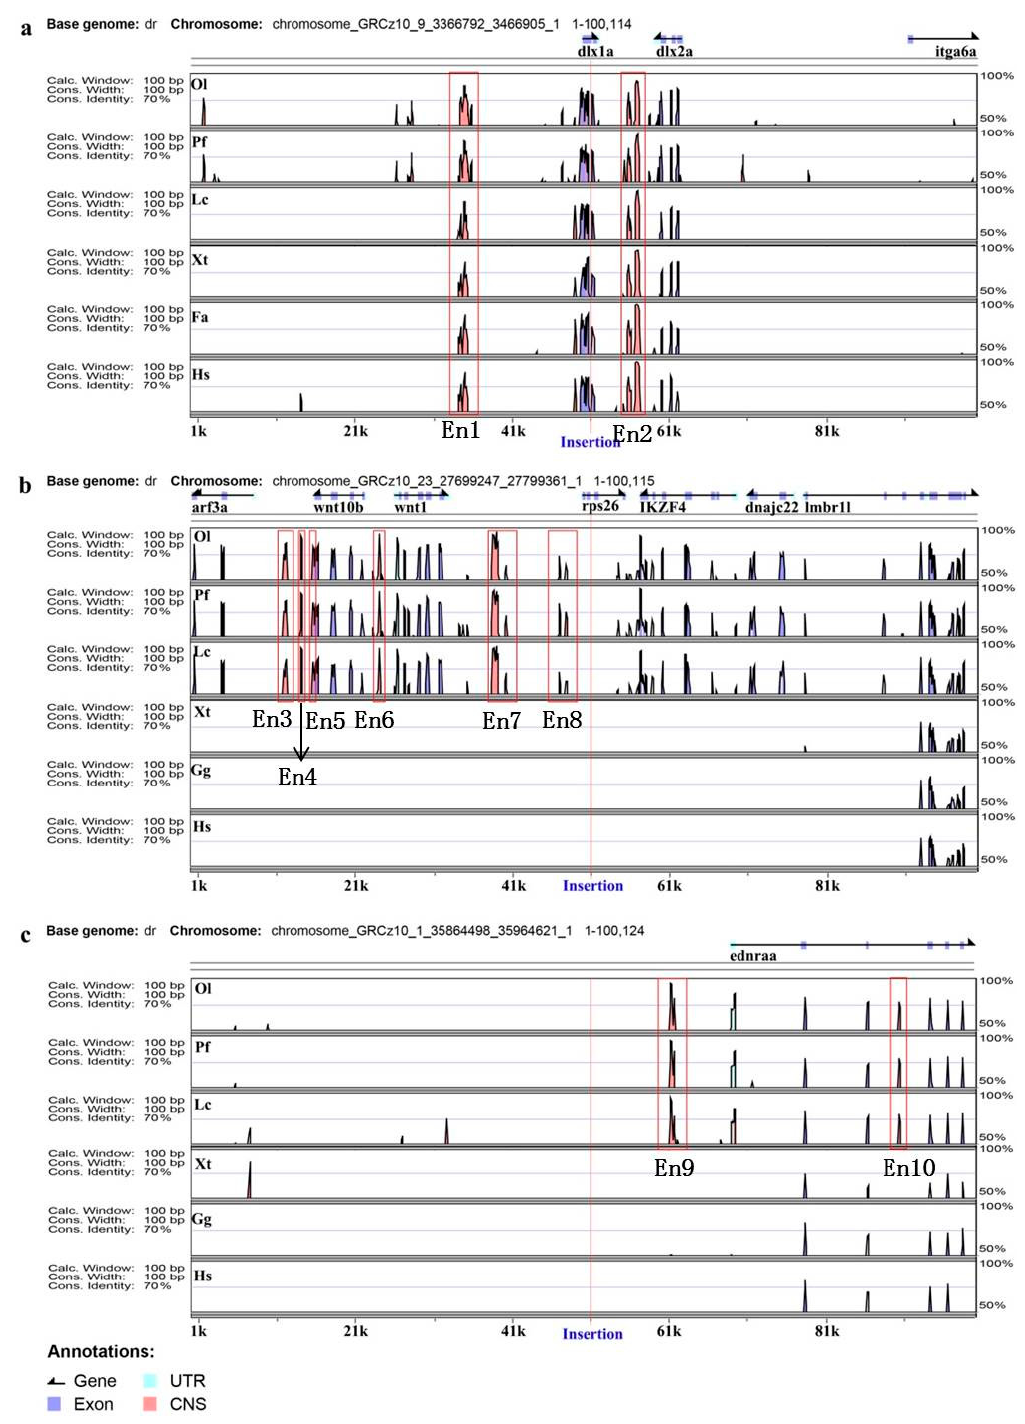
Figure 3. Enhancer annotation of three ET lines. Distribution in the region between 50 kb upstream and 50 kb downstream of insertion. Genomic sequences from Danio rerio (Dr), Oryzias latipes (Ol), Poecilia formosa (Pf), Xenopus tropicalis (Xt), Ficedula albicollis (Fa), Gallus gallus (Gg) and Homo sapiens (Hs) were analyzed in the VISTA browser (https://enhancer.lbl.gov/), and 10 enhancers (Ens) were predicted in zebrafish genome as indicated (red frame); the location of each insertion site is marked with a red line. ( a ), ( b ) and ( c ) represent zebrafish lines TK1, TK4 and SK3, respectively.